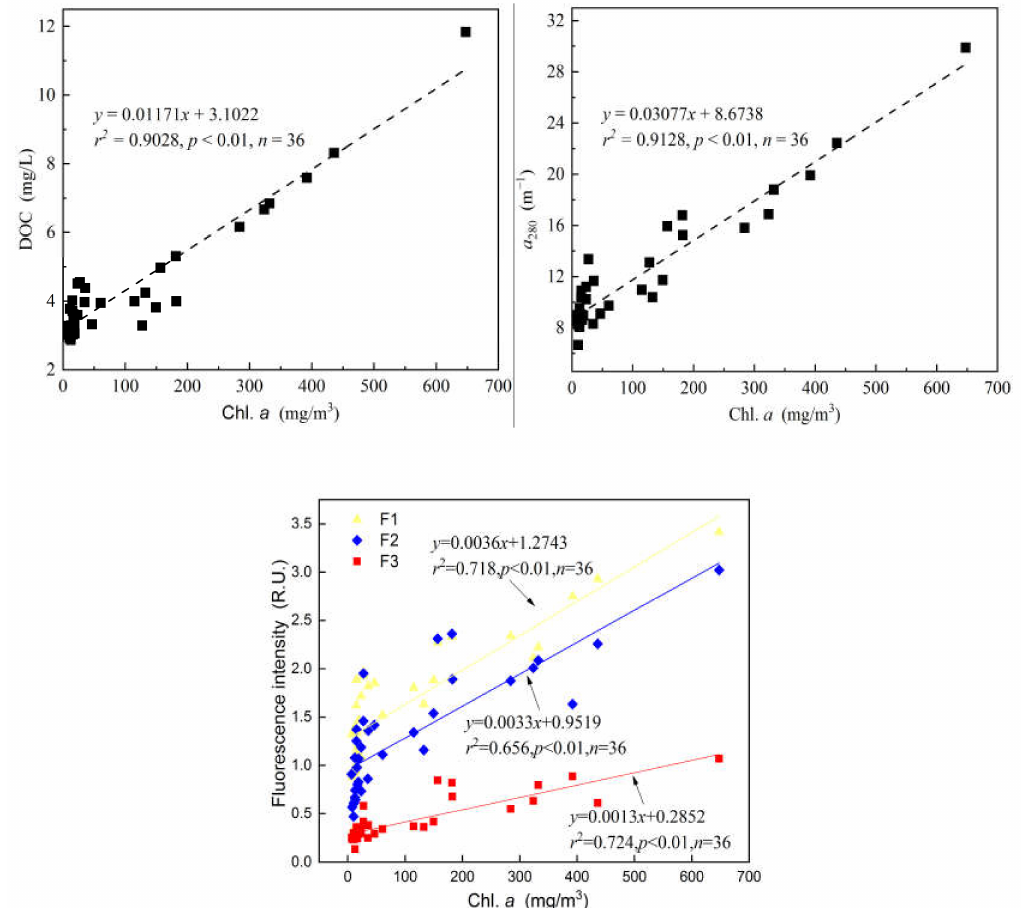
Figure 4. Correlations between dissolved organic carbon (DOC), a 280 , and fluorescence intensities of the components of FDOM and chl. a in the overlying water of Lake